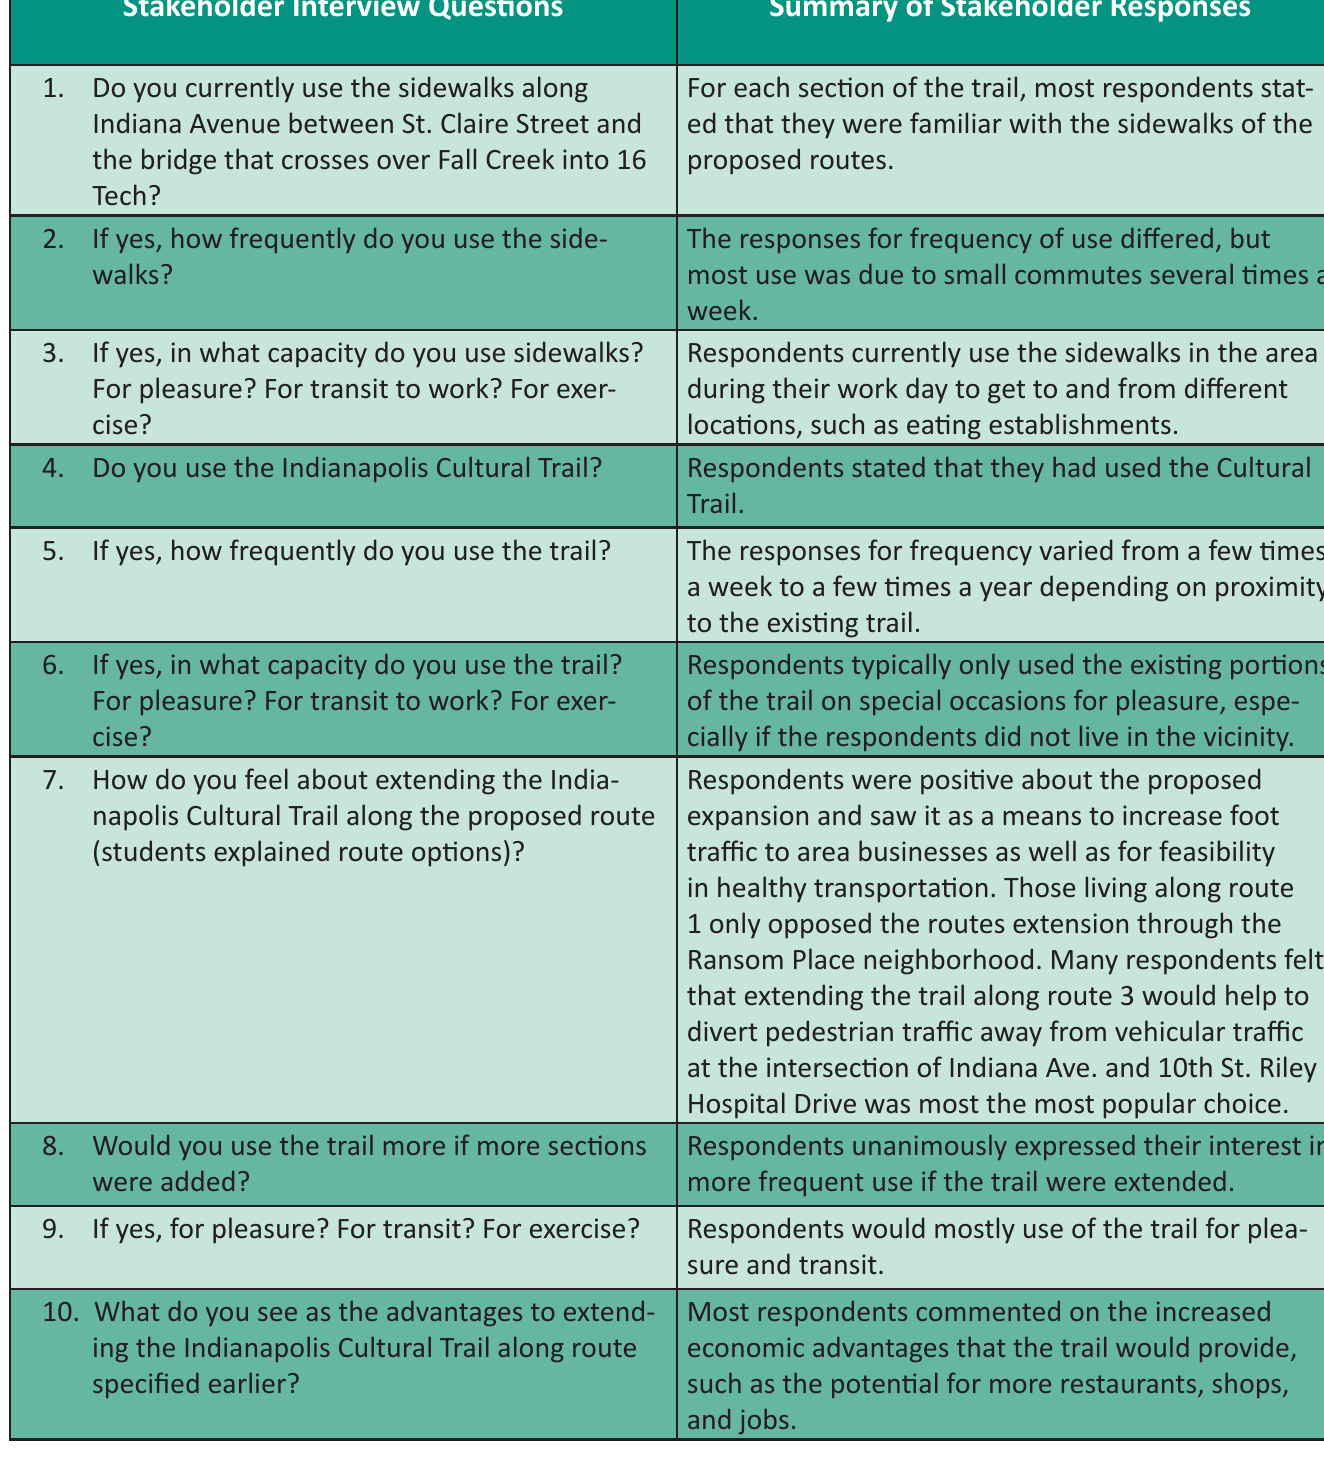
Table 3: Question Guide for Key Informant Interview Questions Stakeholder Interview